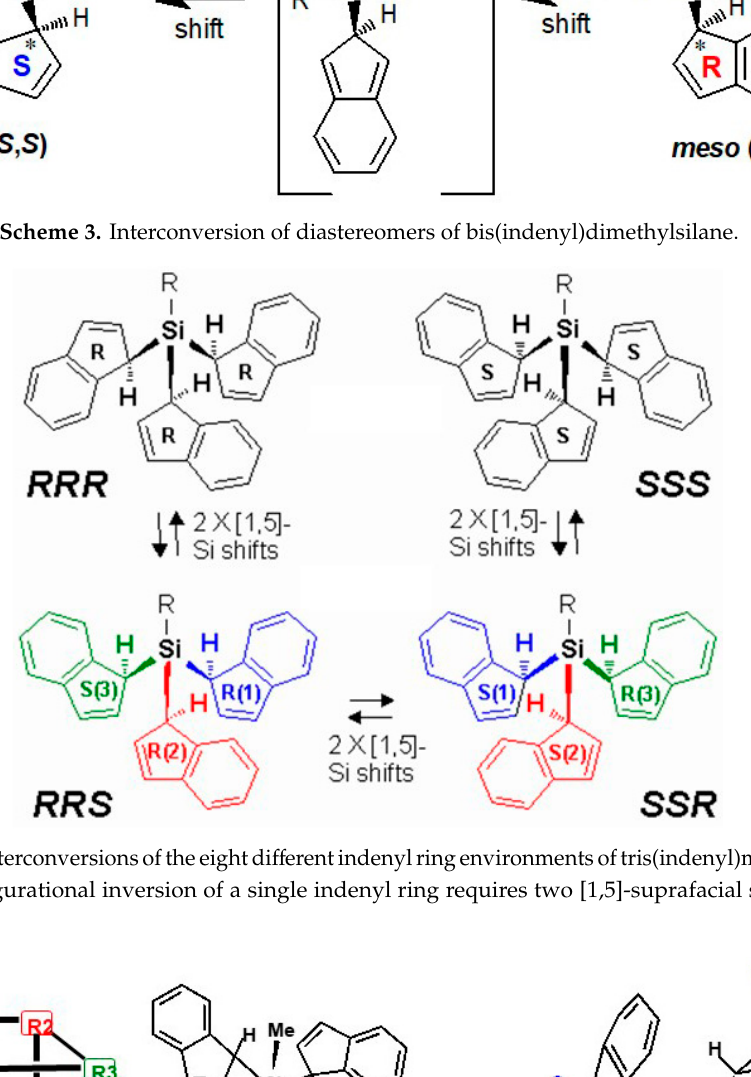
Interconversions of the eight different indenyl ring environments of tris(indenyl)methylsilane, 3 . The configurational inversion of a single indenyl ring requires two [1,5]-suprafacial sigmatropic shifts [17].